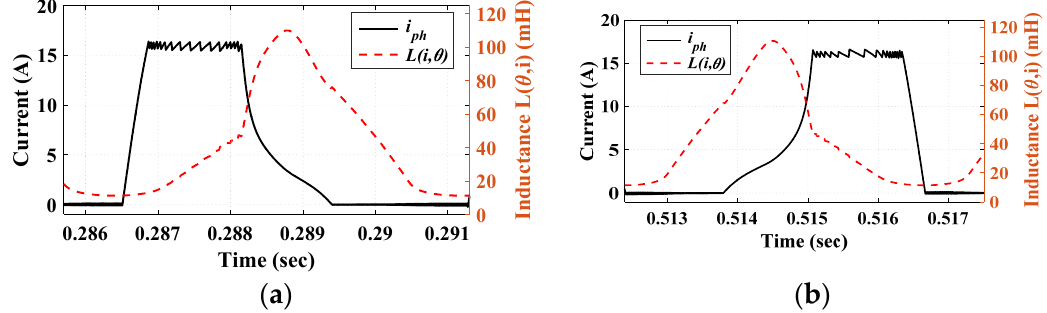
Figure 12. The phase current in: ( a ) motoring mode; ( b ) generating mode.